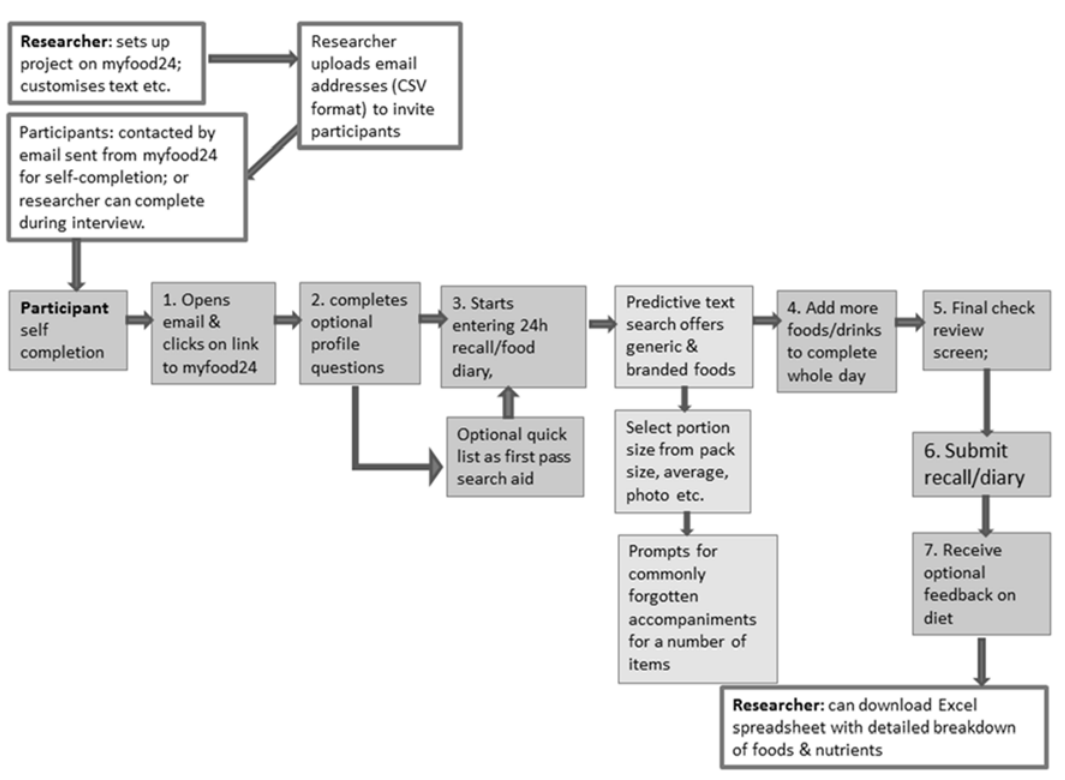
Figure 3. Typical myfood24 workflow for researcher and participant (shaded boxes represent participant actions; unshaded boxes represent researcher